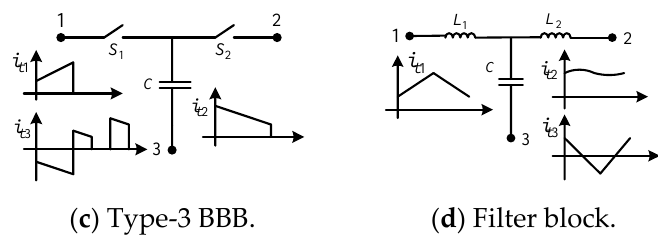
Figure 4. The other basic building blocks and filter block .